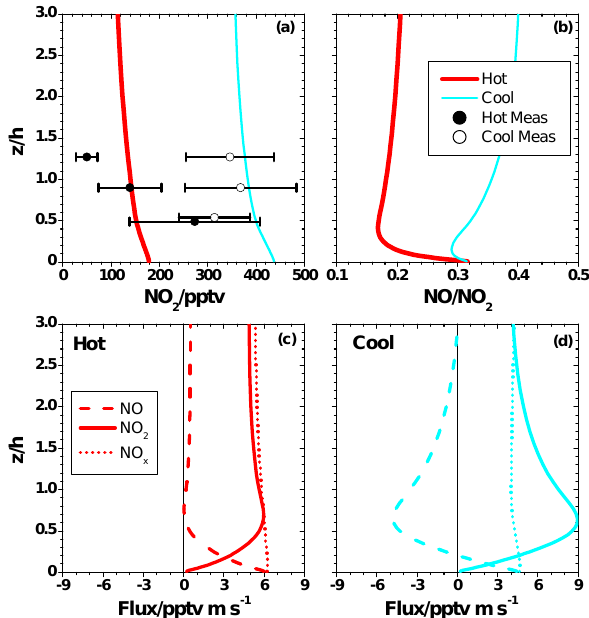
Fig. 7. (a) Vertical NO 2 model profiles for the hot and cool periods. Filled and open circles represent observations (mean ± 1 σ ) for the hot and cool periods, respectively. The lowest cool period observa- tion is offset on the y-axis for clarity. (b) Modeled NO/NO 2 ratios for the hot and cool periods. (c) Modeled flux profiles for NO, NO 2 and NO x for the hot period. (d) As in (c) , but for the cool period.